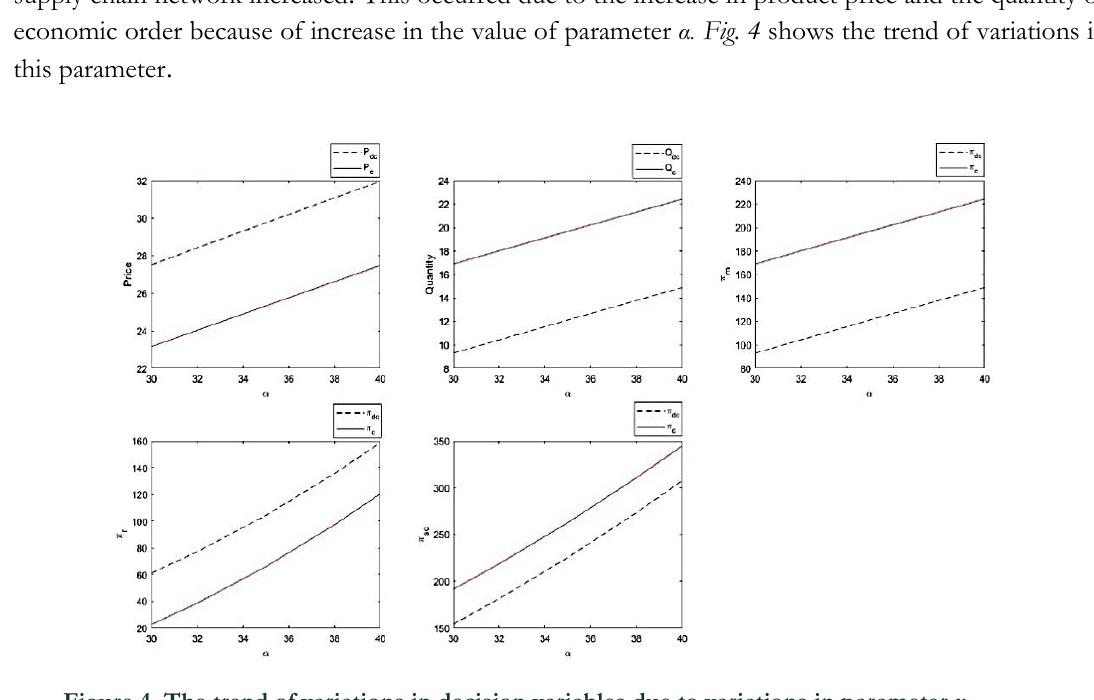
Figure 4. The trend of variations in decision variables due to variations in parameter α . Table 7 and Fig. 5 illustrate the variations in decision variables by parameter β variations . Table 7. Sensitivity analysis of the values of objective functions for parameter β